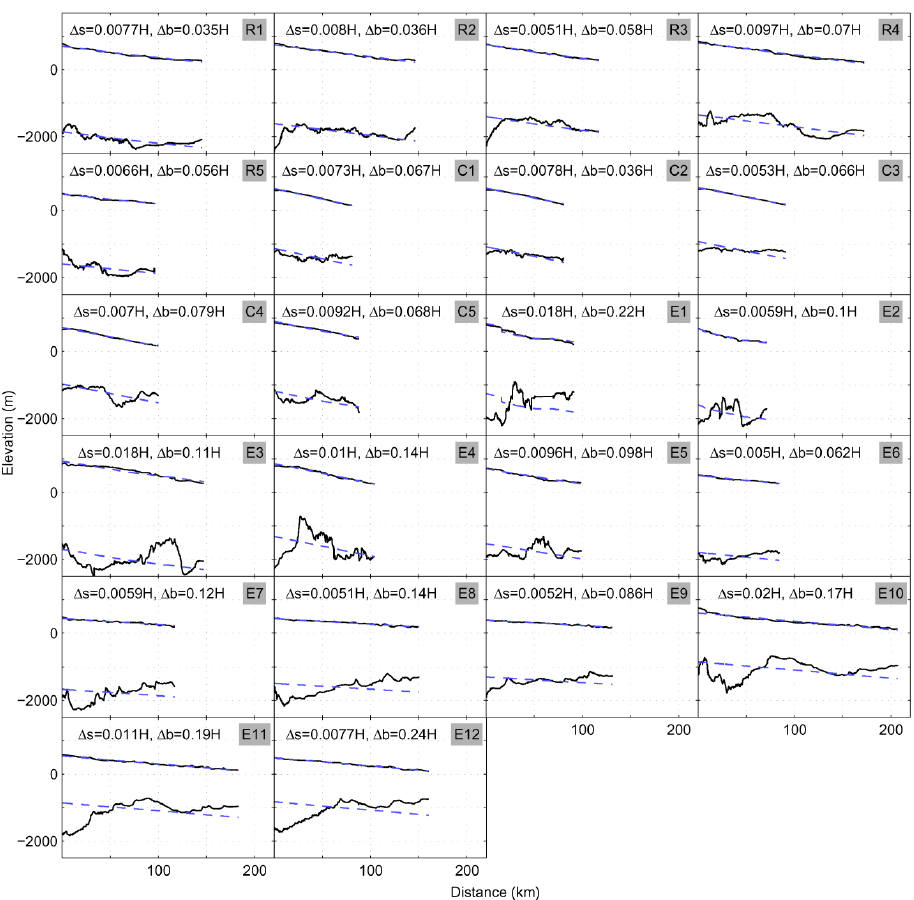
Fig. 3. Black lines show the surface and bed returns along the radar profiles mapped in Fig. 2; dashed blue lines represent the plane-slab approximation used in this work; and 1s and 1b are the mean amplitude of the surface and bed deviations. More details can be found in Sect.